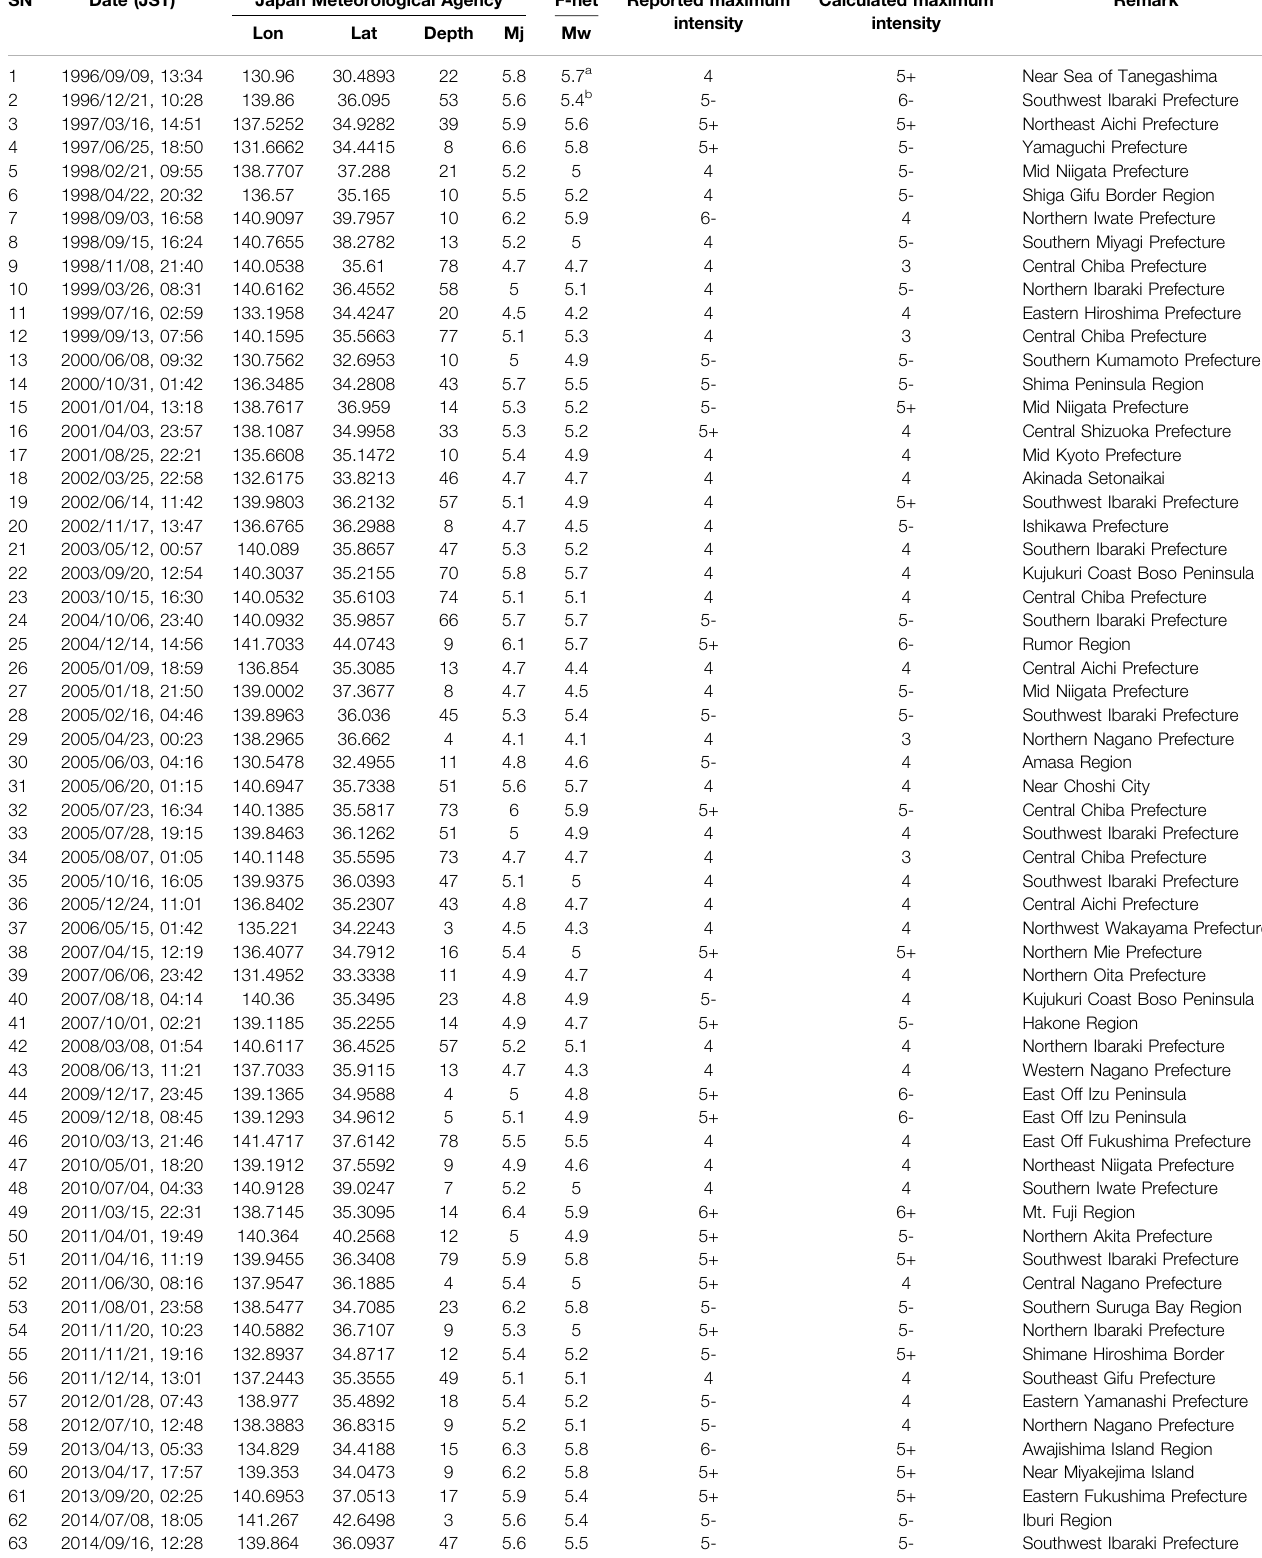
TABLE 1 | List of damaging moderate magnitude earthquakes in Japan.